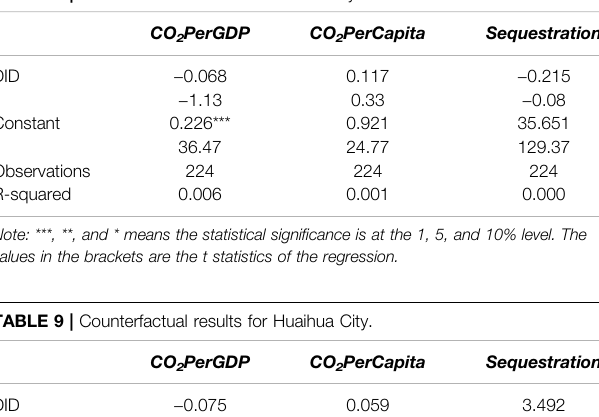
TABLE 8 | Counterfactual results for Jinhua City.